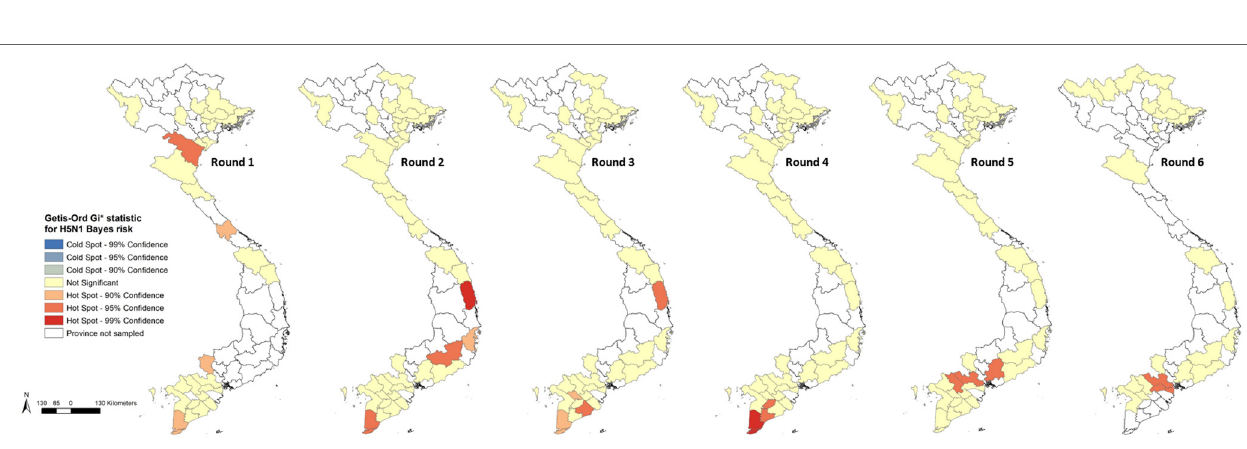
FigUre 3 | Getis-Ord GI* statistic maps showing hot-spot provinces for highly pathogenic avian influenza H5N1 Bayes risk for Rounds 1–6.